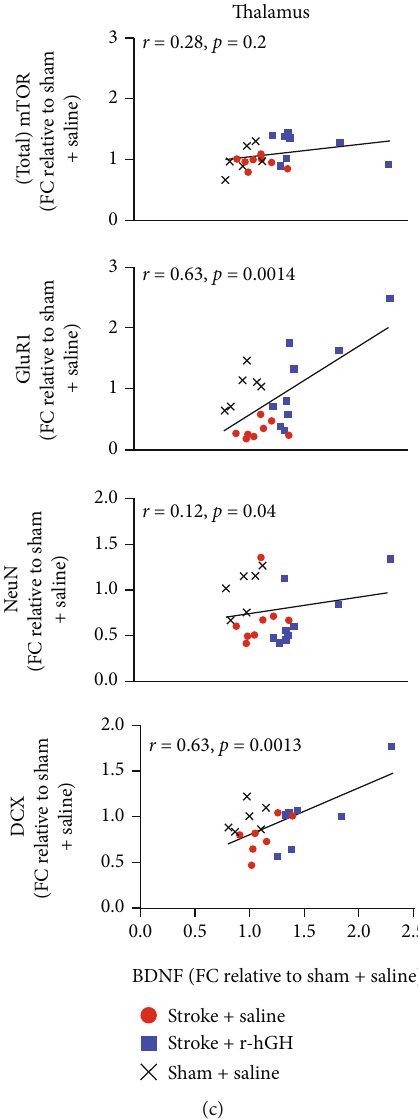
Figure 5: Correlation of uncleaved immature form of BDNF (pro-BDNF) with mammalian target of rapamycin (mTOR) and markers of neuroplasticity. Correlation of pro-BDNF, with T-mTOR (top panel), α -amino-3-hydroxy-5-methyl-4-isoxazolepropionic acid (AMPA)- receptor subunit GluR1 (marker of synaptic plasticity, second from top panel), NeuN (neuronal marker, third from top panel), and doublecortin (DCX, neuronal migration marker, bottom panel) in the peri-infarct region (a), hippocampus (b), and thalamus (c). Dataset GluR1, NeuN, and DCX was an excerpt from previous study [9, 28]. Correlations contain all three experimental groups, Sham+Saline (black crosses), Stroke+Saline (red circles), and Stroke+r-hGH (blue squares) and analyzed using Pearson ’ s correlation. Pearson ’ s r and associated p values for each correlation are reported on the corresponding